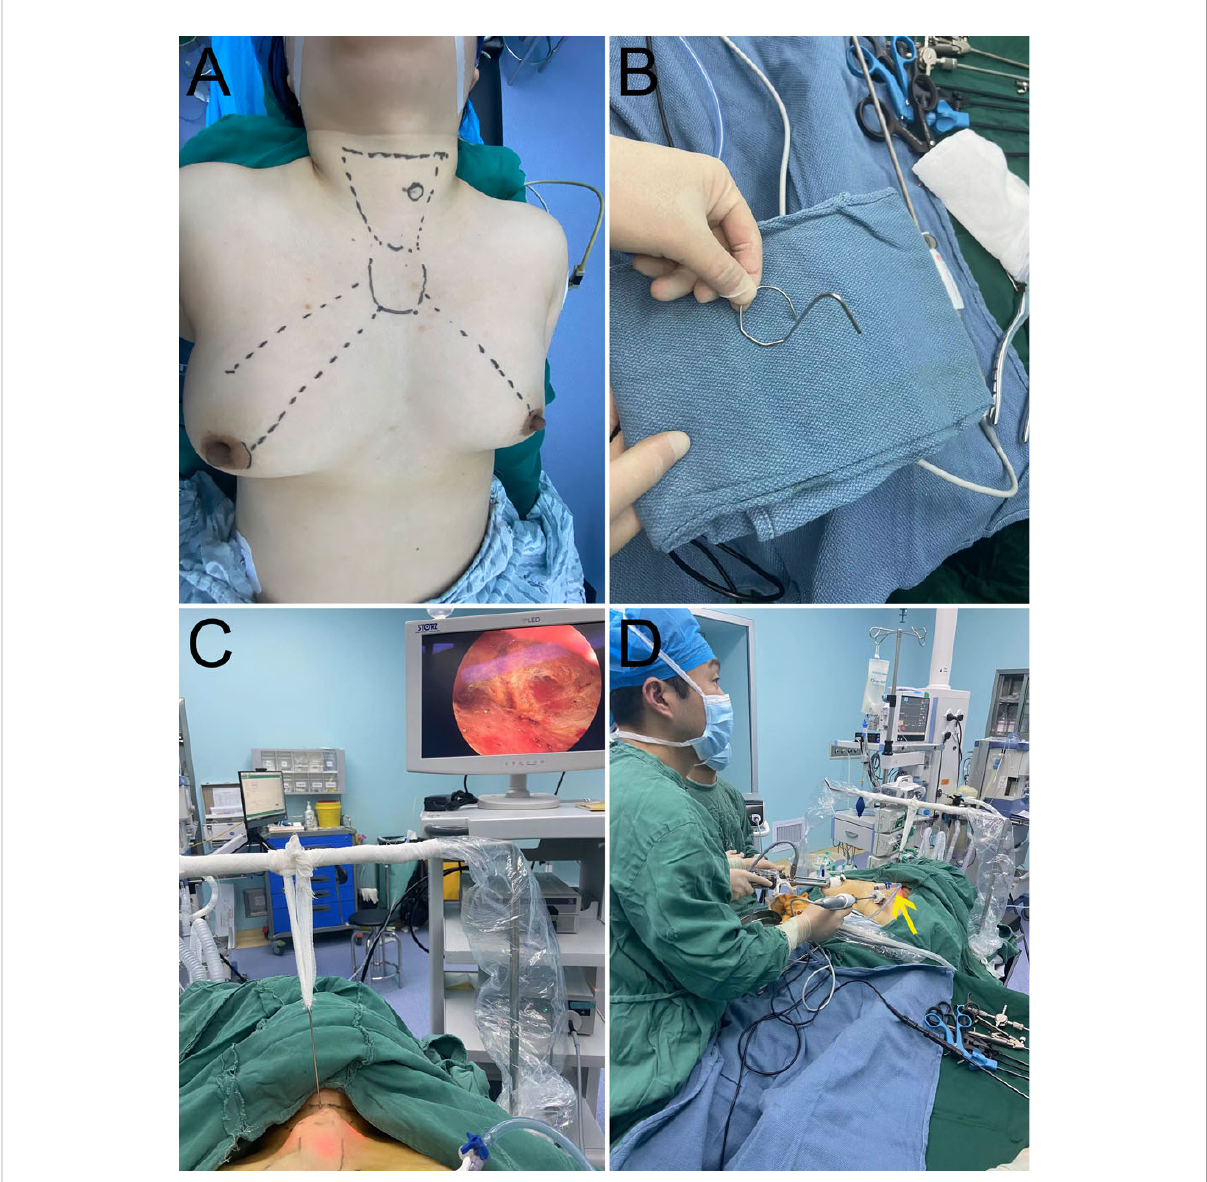
FIGURE 1 (A) Operation area and incision design; (B) Appearance of K-wire hook; (C) External schematic diagram of K-wire hook suspension device; (D) Overall surgical scene (yellow arrowheads: smoke suction